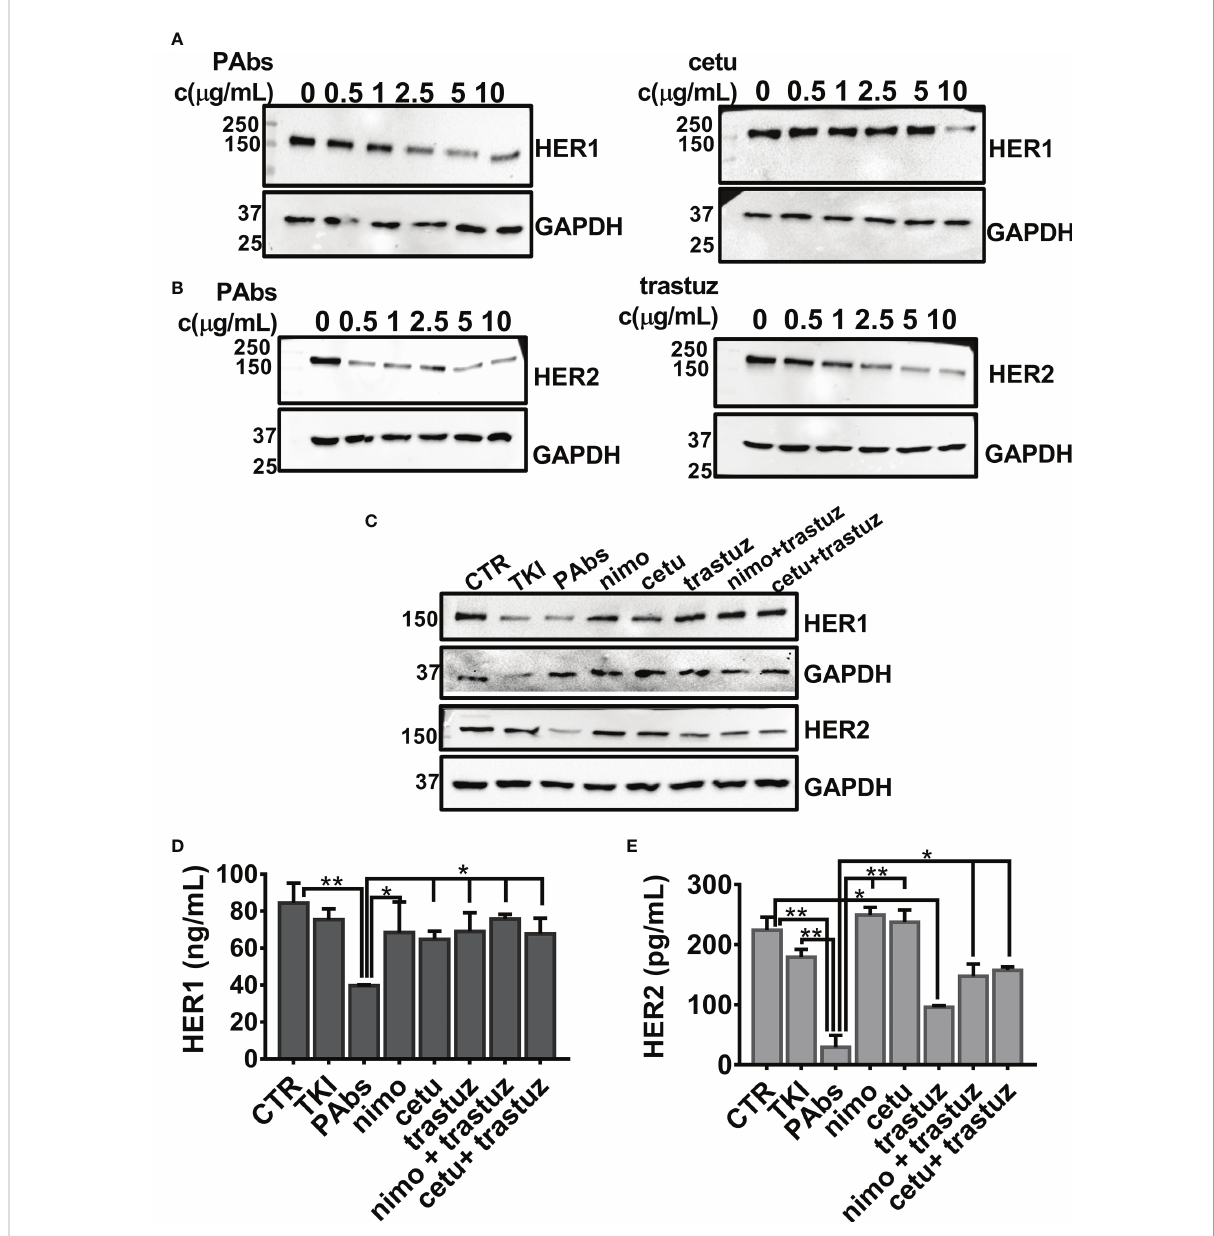
FIGURE 3 Comparative evaluation of the degradation of HER1 and HER2 in H292 cells expressing wild-type HER1. For dose-curve assessment, H292 cells were treated for 24 h with increasing concentrations (0, 0.5, 1, 2.5, 5, and 10 µg/ml) of the PAbs, cetuximab (cetu), or trastuzumab (trastuz). Thereafter, cells were washed with cold saline and lysed. Next, (A) HER1 (3 µg of total lysates) and (B) HER2 (30 µg of total lysates) expression levels were analyzed by Western blot. Detection of GAPDH was included as loading control for individual membranes. (C) For point-dose evaluation, H292 cells were treated for 24 h with the PAbs (10 µg/ml), or with combinations of cetuximab (cetu, 10 µg/ml) or nimotuzumab (nimo, 10 µg/ml) with trastuzumab (trastuz, 1 µg/ml). Unspeci fi c PAbs (CTR, 10 µg/ml), single MAbs, or TKI AG1478 (10 µM) was included as controls. As previously described, expression levels of HER1 (3 µg of total lysates) and HER2 (30 µg of total lysates) were analyzed by Western blot, including GAPDH detection as loading control. Alternatively, quantitative ELISA was performed to measure (D) HER1 and (E) HER2 in the lysates of H292 cells treated as in (C) , following the manufacturer ’ s instructions. In the graphs, data are means ± SD corresponding to triplicates. A representative experiment of three performed is shown. Group means were compared using Kruskal – Wallis test followed by a Games – Howell post-test. Signi fi cant differences among PAbs and control, MAbs or its combinations are represented * p < 0.05; ** p < 0.01. MWM — molecular weight